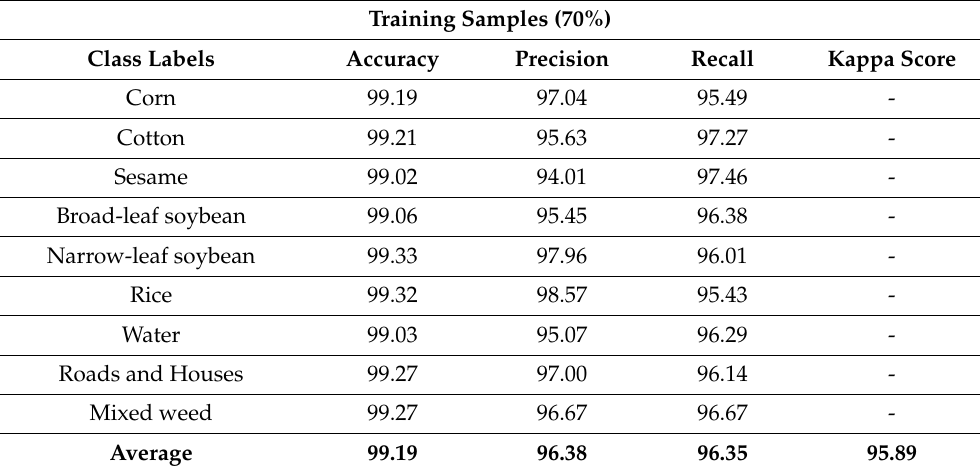
Table 2. Result analysis of the SSODTL-CC technique with distinct classes under 70% of training dataset-1.